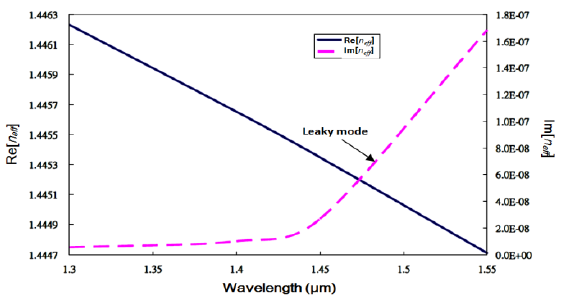
Figure 4. Dispersion curves of the fundamental leaky mode for a PCF with two air-hole rings (18 air-holes) , where Λ = 6.75 μm, d = 5 μm, and n silica = 1.45.